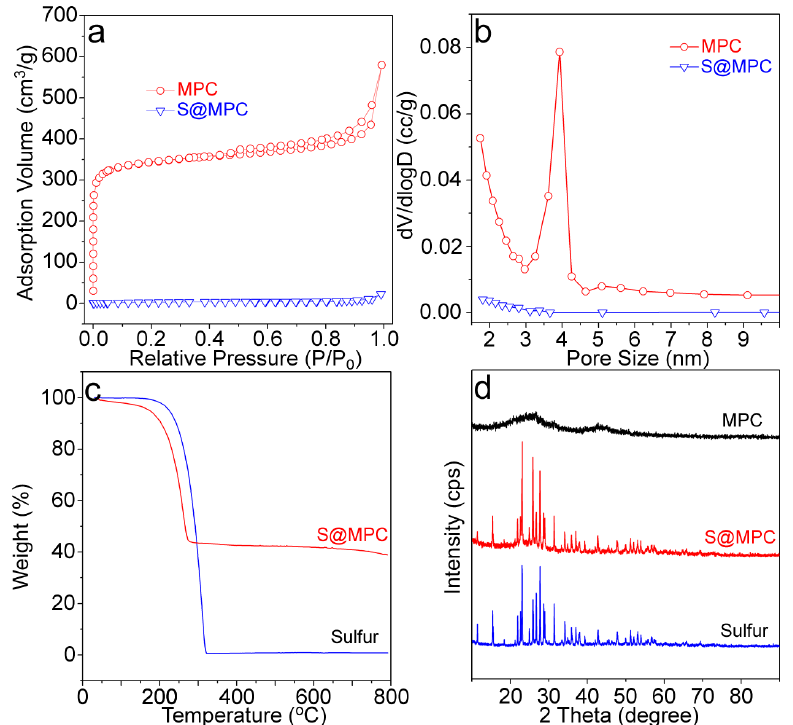
Figure 4. ( a ) N 2 adsorption-desorption isotherms; ( b ) BJH pore size distribution; ( c ) TGA curves of the sulfur and S@MPC materials; ( d ) XRD patterns of the MPC, sulfur, and S@MPC materials. Note: XRD backgrounds of these samples were shifted for better comparison.